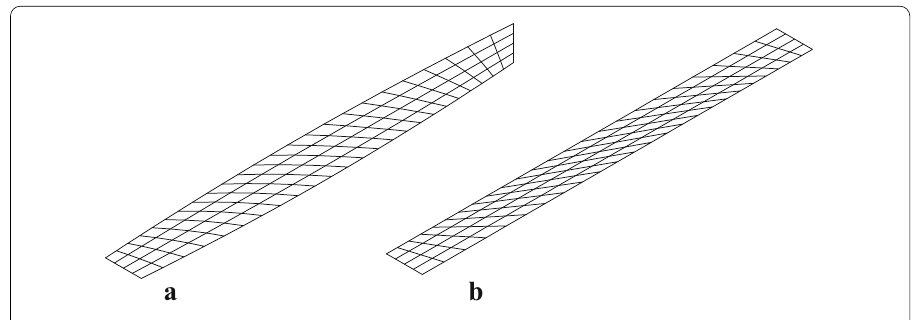
Fig. 20 Twisted beam: distorted 4 × 24 mesh 2, a perspective view, b perspective view of the flat projection